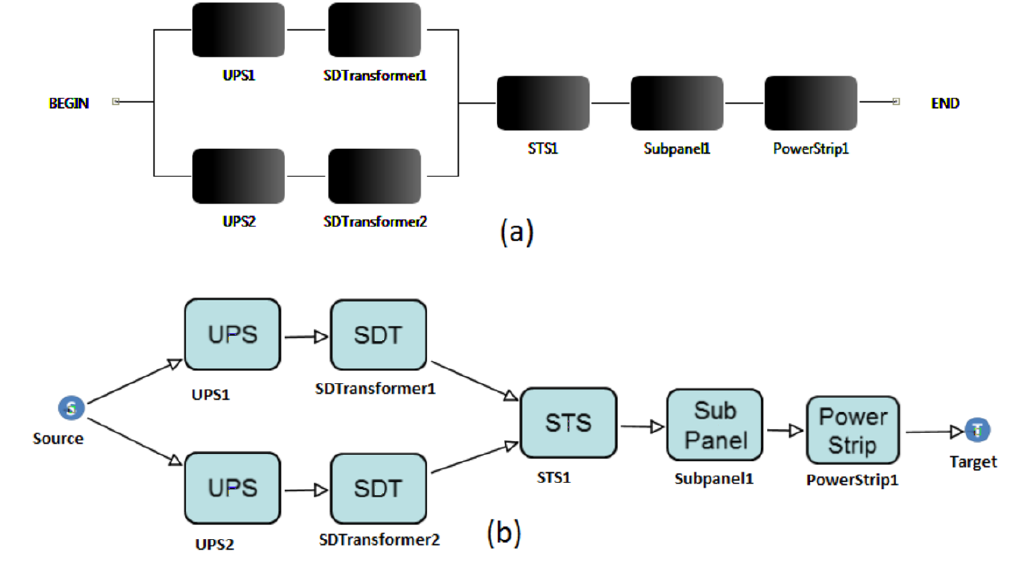
Figure 13. ( a ) RBD and ( b ) EFM models for architecture A3.